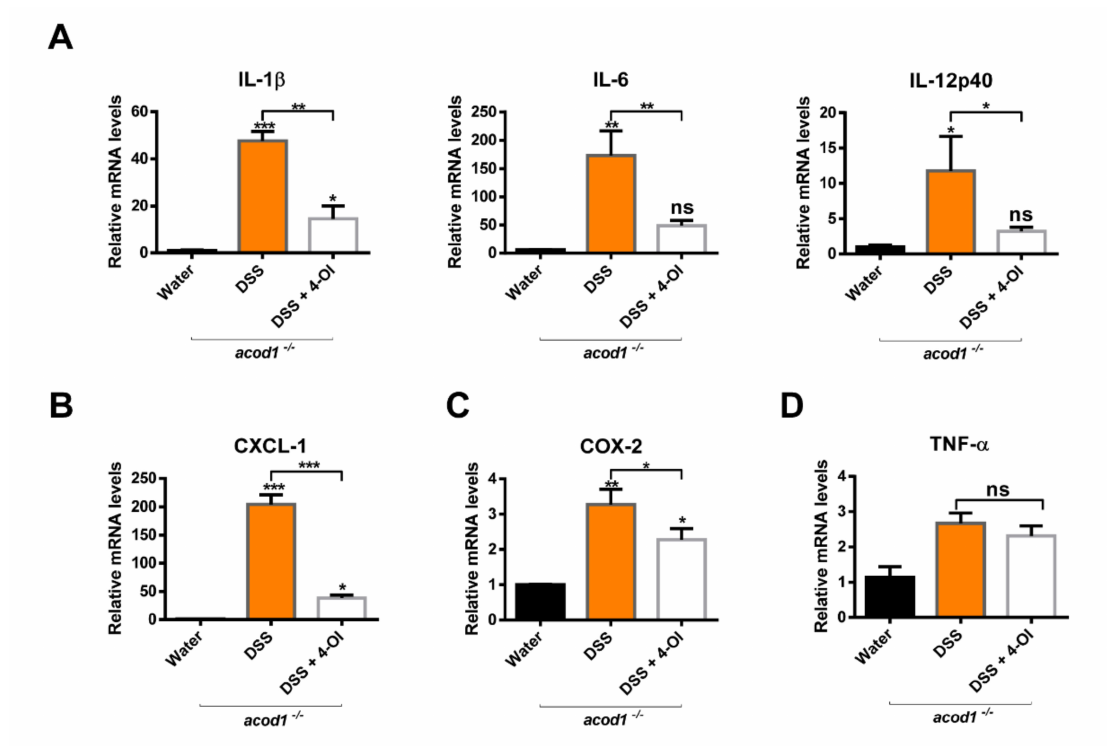
Figure 6. Effects of 4-octyl itaconate (4-OI) on inflammatory cytokine expression in acod1 − / − mice with DSS-induced colitis. The mRNA levels of IL-1 β , IL-6, and IL-12p40 ( A ); CXCL-1 ( B ); COX-2 ( C ); and TNF- α ( D ) in the colonic tissues were determined by quantitative real time-PCR. Expression was normalized to that of β -actin, and each bar represents the mean ± SD. Symbols *, **, and *** denote p < 0.05, p < 0.01, and p < 0.001,